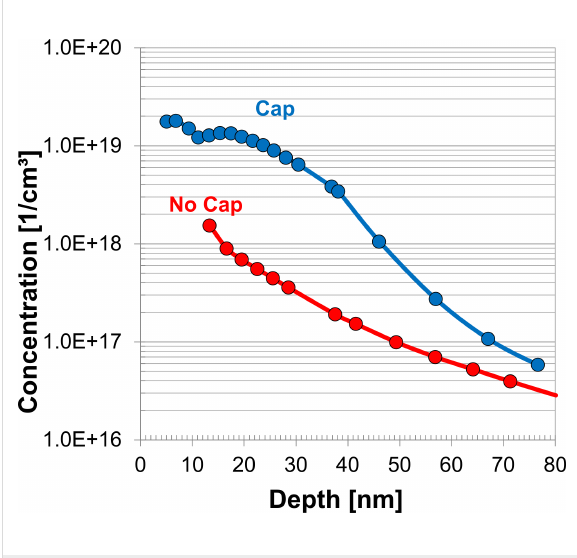
Figure 2: Electrochemical capacitance–voltage profile showing the impact of applying a SiO 2 capping layer for the duration of the annealing process. Both samples were annealed at 1050 °C for 5 s (the inset shows the allyldiphenylphosphine dopant molecule).